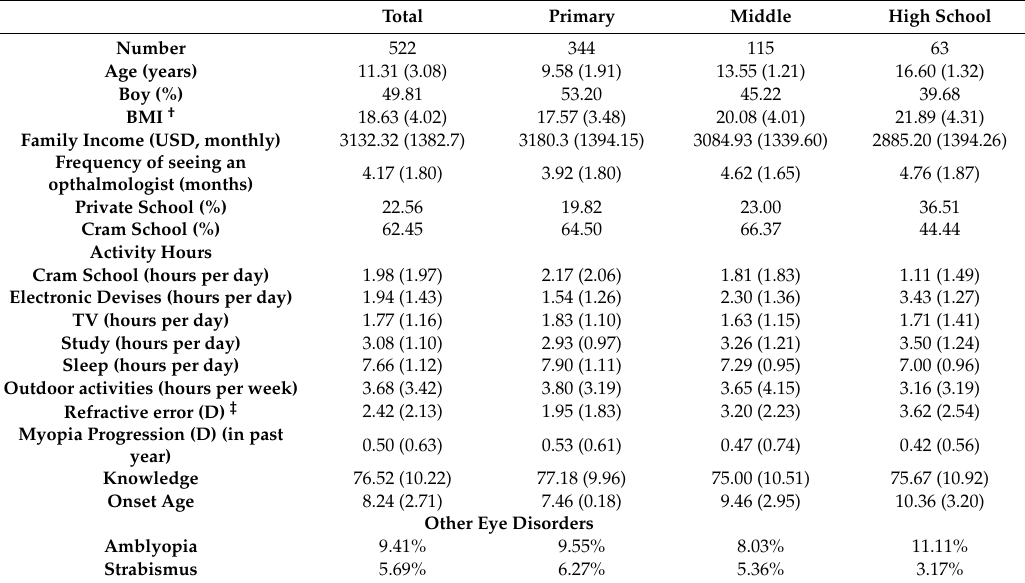
Table 1. Subject demographic information.